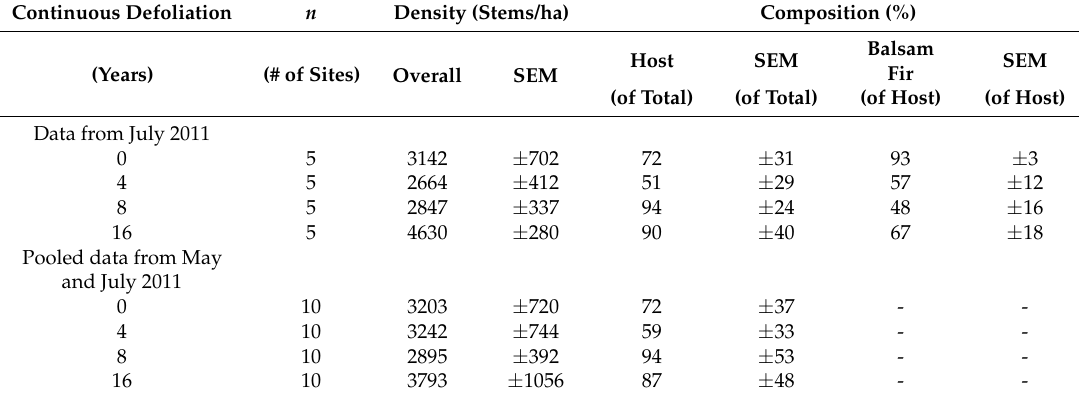
Table 2. Overstory tree (DBH ≥ 3 cm) density and composition in zones of boreal mixedwood forest continuously defoliated by spruce budworm for zero, four, eight and sixteen years from 1993–2008 near Warren, Ontario. Forest characteristics were measured at five sites within each defoliation zone in May 2011. The same measurements were repeated at independent sites in July 2011. The pooled data (i.e., ten sites per defoliation zone) are shown separately from the data collected in July 2011. Standard error of the mean is represented by SEM. Host trees include balsam fir, white spruce and black spruce.